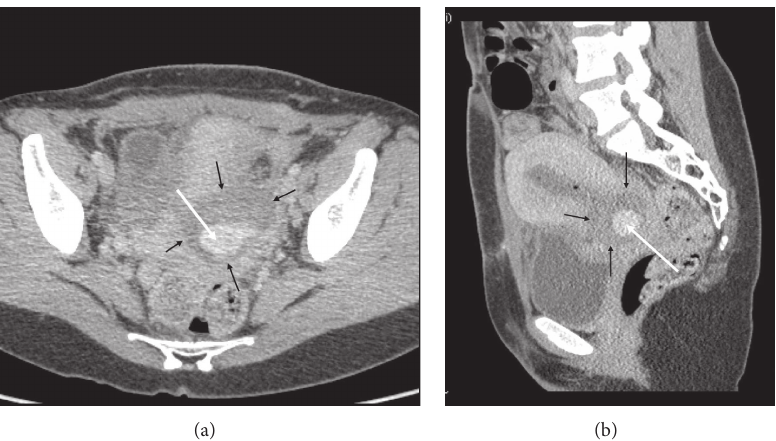
Figure 1: CT angiography of pelvis with axial (a) and sagittal (b) images. The large hematoma is located at the left part of pelvis in the wall of cervix (black arrows). The white contrast shows the leakage into the hematoma (white arrow).